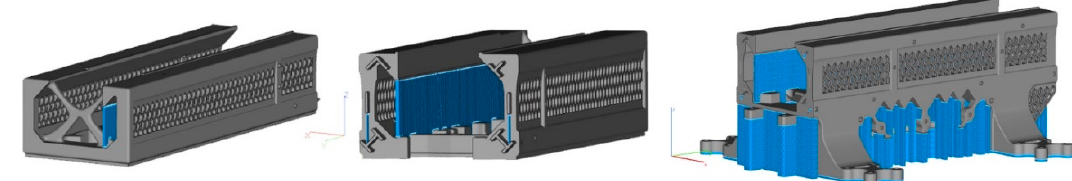
Figure 6. The layout of the parts with the support structure (in blue). All supports can be removed manually, except the ones on the bottom surfaces which are removed during the detachment of the parts from the building platform by EDM.